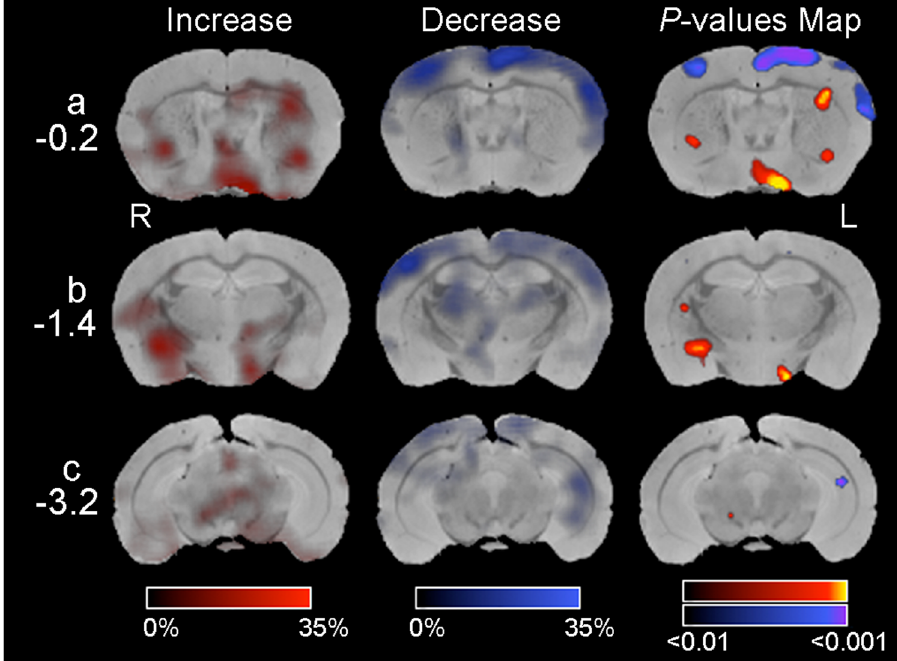
Figure 3. Changes of regional cerebral blood flow (rCBF) in Nptn loxloxEmx1Cre brain. Compared to control Nptn lox/lox mice, brain areas with increased rCBF in Nptn loxloxEmx1Cre mice are indicated in red (Increase, left column) and with decreased rCBF in blue (Decrease, middle column). rCBF in mutant mice was scored as % of change relative to control mice. P-values Map (right column) scores changes in rCBF according to their statistical significance level in the color-ranged bars from P < 0.01 to P < 0.001. R, right brain hemisphere. L, left. Distances from bregma are indicated ( − 0.2, − 1.4, and −